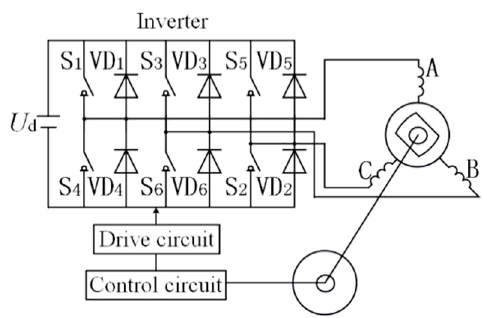
Figure 7. The three-phase brushless DC motor system.